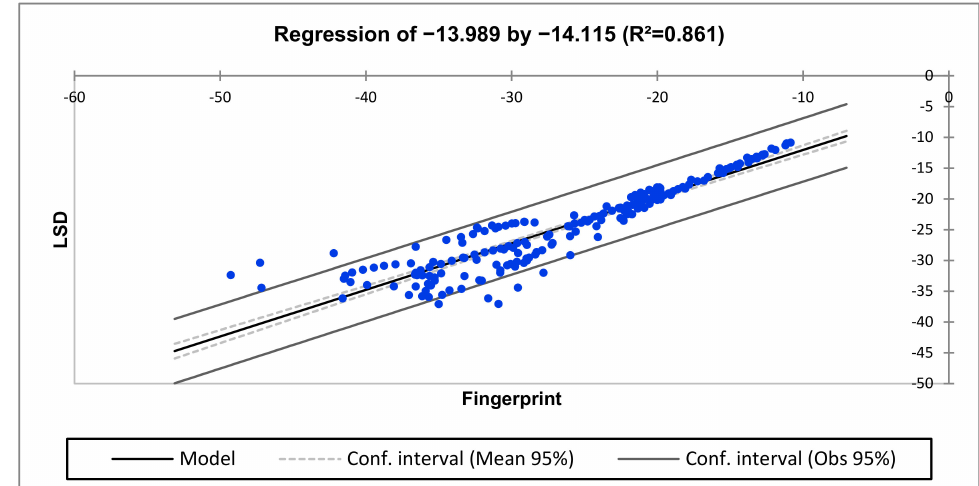
Figure 23. Regression for H2-H1 vs. H3-H2 (high-frequency region).